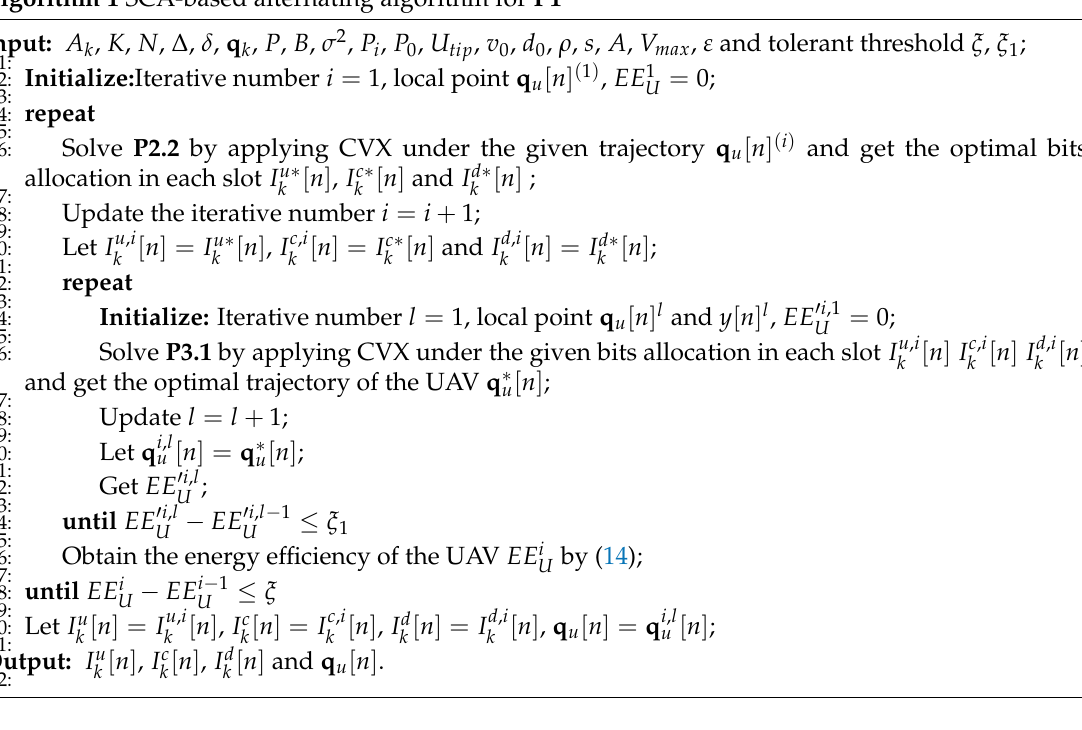
Algorithm 1 SCA-based alternating algorithm for